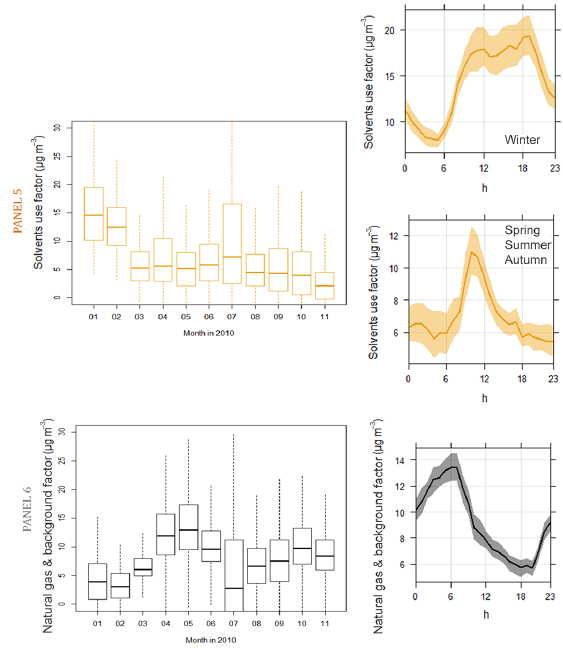
Figure 10. Left: monthly box and whisker plots of modeled sources from the six-factor solution. Concentration levels are expressed in µgm − 3 . Solid lines represent the median concentrations and the box shows the IQR. The bottom and top of the box depict the 25th (the first quartile) and the 75th (the third quartile) percentile. The ends of the whiskers correspond to the lowest and highest data still within 1.5 times the IQR of Q1 and Q3, respectively. Right: diurnal varia- tions of the resolved PMF factors. Time is given in local time. Lines correspond to hourly means and shaded areas indicate the 95% con- fidence intervals of the